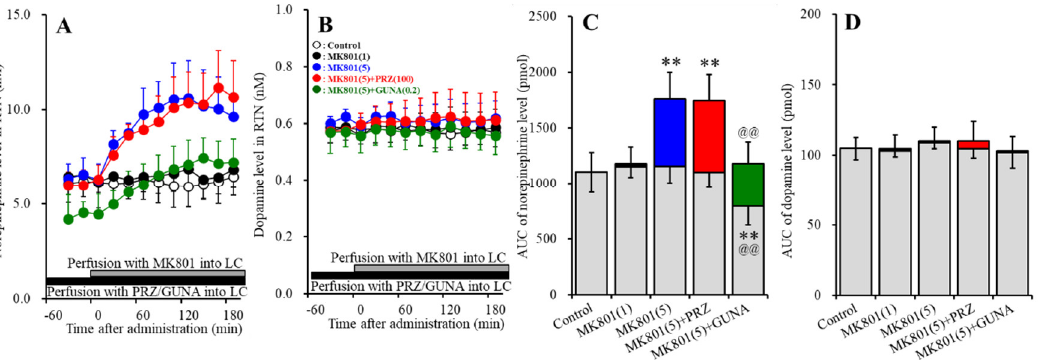
Figure 2. Effects of local administration of PRZ and GUNA into the LC on MK801-induced releases of norepinephrine ( A ) and dopamine ( B ) in the reticular thalamic nucleus (RTN). Ordinates: mean ± SD (n = 6) of extracellular catecholamine levels (nM); abscissa: time after MK801 administration (min). Black bars indicate perfusion with 100 µ M PRZ or 0.2 µ M GUNA into the LC. Gray bars indicate perfusion with 1 µ M and 5 µ M MK801 into the LC. ( C , D ) indicate the AUC values of extracellular levels of norepinephrine and dopamine (pmol) after perfusion with MK801 (from 20 to 180 min), based on ( A ) and ( B ), respectively. Gray columns represent the AUC values before perfusion with MK801 (basal release). ** p < 0.01; relative to control, and @@ p < 0.01; relative to MK801 (5 µ M) by MANOVA with Tukey’s post hoc test.